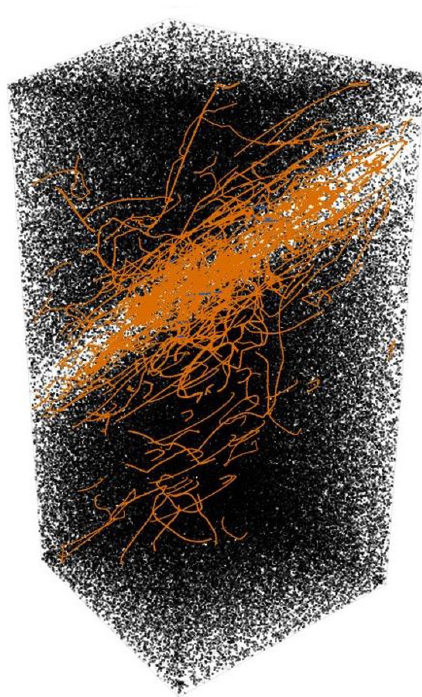
Figure 9. (color online) Distribution of irradiation defects and dislocation configurations when the irradiation dose equals 0.375 dpa for neutron-irradiated iron. Numerical results are performed by coupled Field-dislocation dynamics simulations. (Reprinted with permission from [35]. Copyright 2018 by